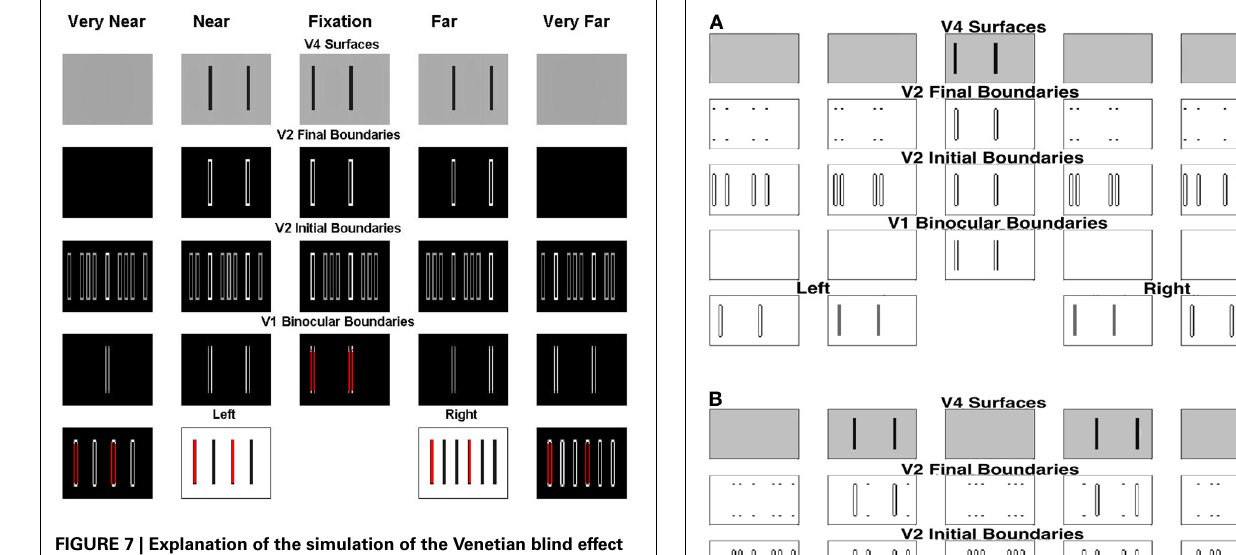
boundaries in the very near and very far depths (the first plot and the last plot of the second row) will all be killed. But